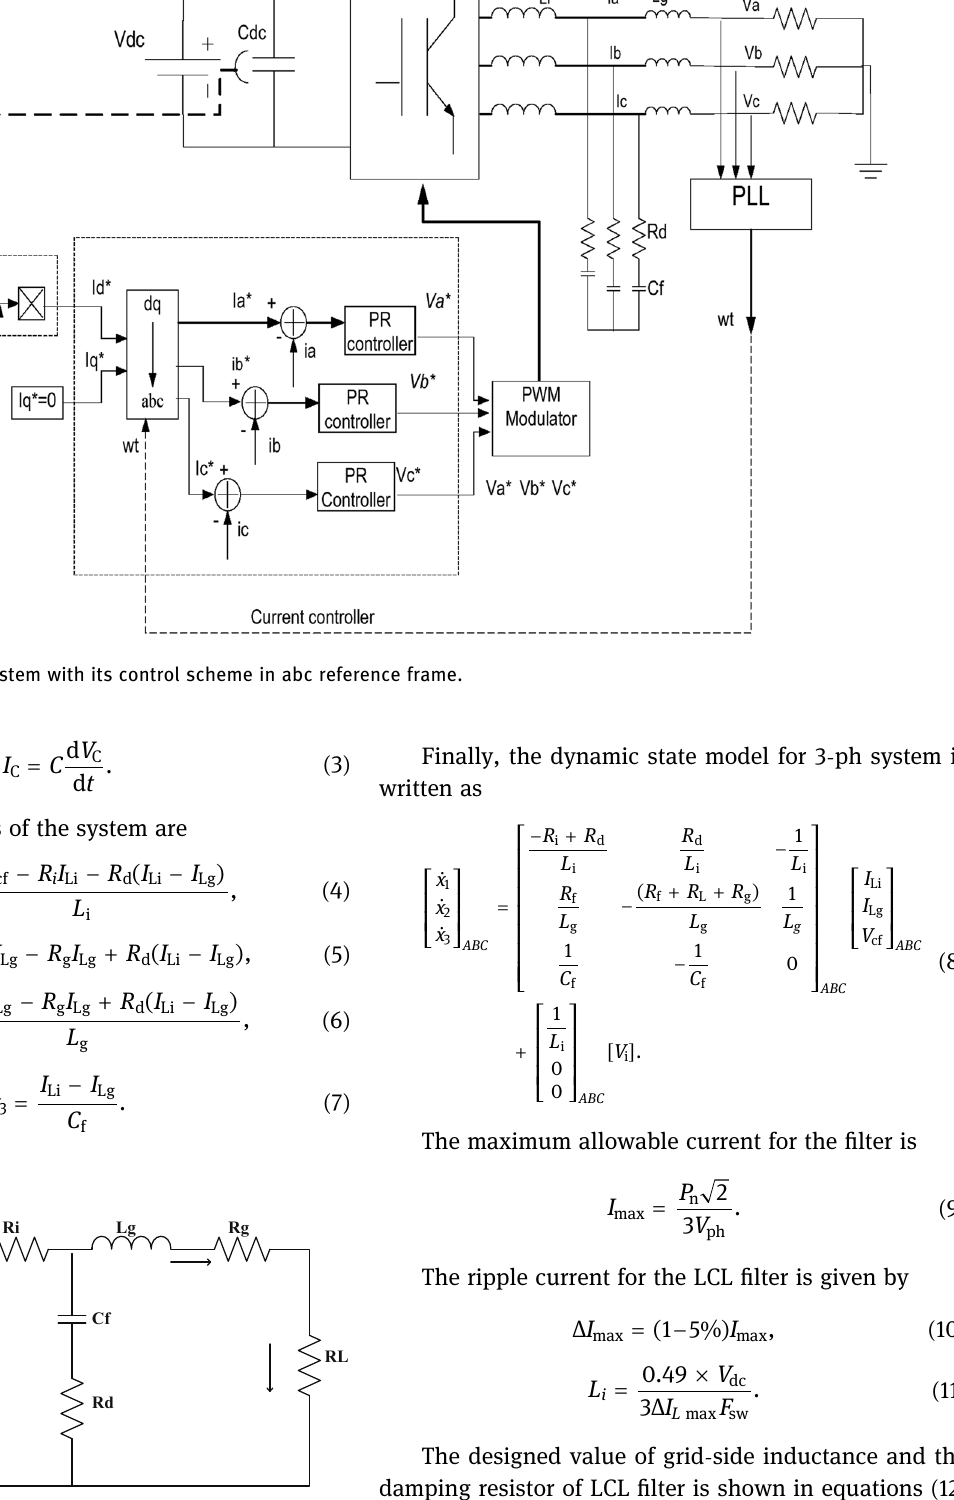
Figure 6: LCL fi lter with 3 - ph inverter